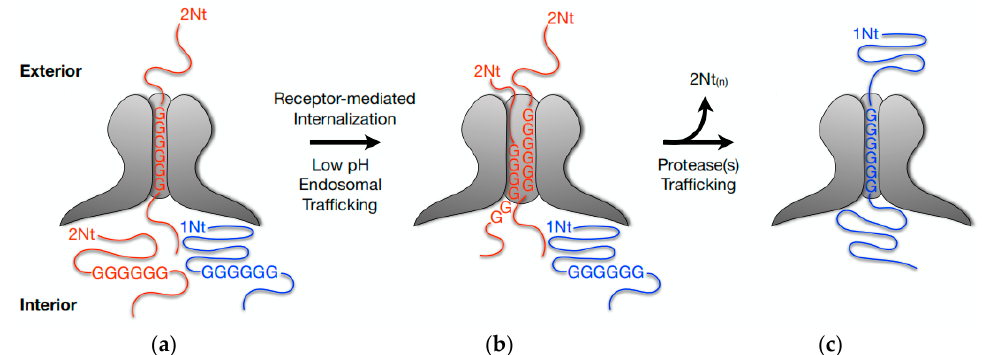
Figure 2. Model of the sequential externalization of VPs N-terminal sequences at the capsid pore during MVM entry: ( a ) In the extracellular virion the N-terminal sequence of VP2 subunits (VP2-Nt or 2Nt) are externalized through the capsid channel at the five-fold axis without impairing infectivity. One subunit anchored by the poly-Gly track is illustrated; ( b ) Upon receptor-mediated internalization and low pH exposure inside the endosome, internal VP2 N-termini access the base of the pore enlarging the functional diameter of the channel as they become extruded to the capsid exterior; ( c ) Most de novo exposed VP2 N-termini are cleaved-off from the capsid surface. The incoming virion traffics to downstream endosomal compartment(s), with presumed lower protease pools, where the VP1 N-terminus (or 1Nt) is entirely externalized becoming anchored by its poly-Gly track, as the channel returns to a narrow configuration. 1Nt (or VP1-Nt), the VP1-unique N-terminal sequence (143 amino acids); 2Nt (or VP2-Nt), the VP2 N-terminal sequence (27 amino acids); GGGG, poly-Glycine track. Based on references [82,91].